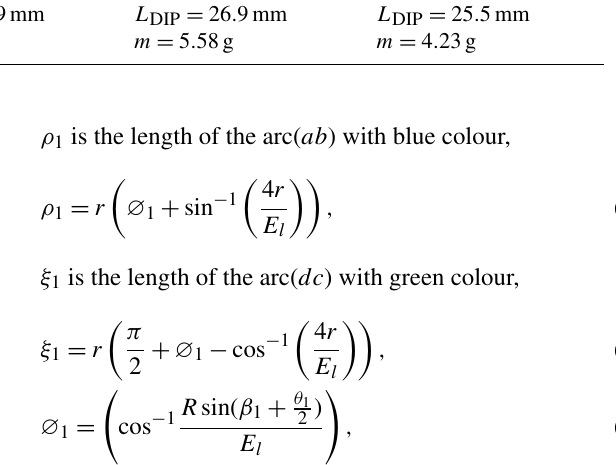
Table 1. The average dimension of the human hand finger. The index finger The middle finger The ring finger The small finger L PP = 52 . 2mm L PP = 50 . 6mm L PP = 39 . 6mm Proximal phalanges L PP = 56 . 8mm m = 19 . 27g m = 17 . 69g m = 9 . 13g Middle phalanges L MP = 21 . 8mm Small phalanges